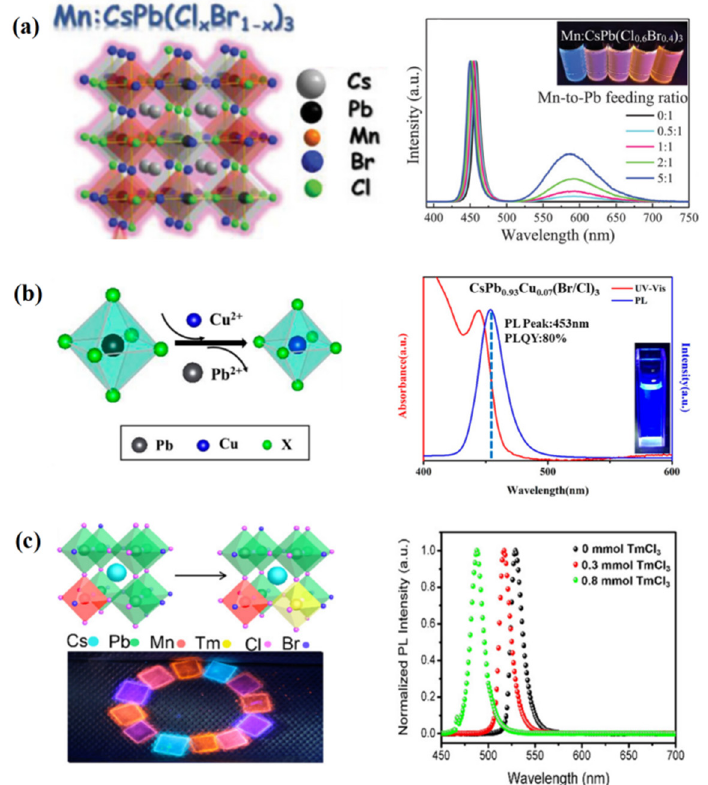
Figure 5. ( a ) Mn 2+ doping. Reproduced with permission from [71]. Copyright 2019, Wiley. ( b ) Cu 2+ doping. Adapted with permission from [67]. Copyright 2019, American Chemical Society. ( c ) Tm 3+ doping. Adapted with permission from [66]. Copyright 2019, American Chemical Society.